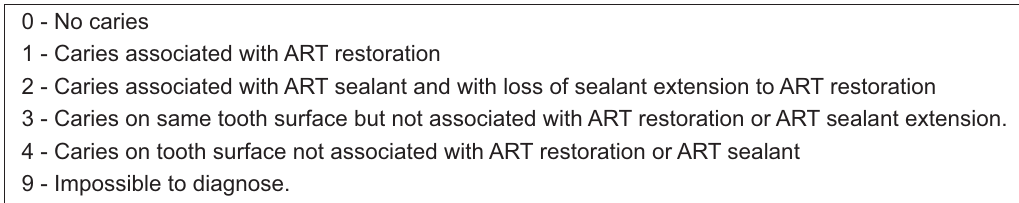
Figure 3 - Criteria for diagnosing carious lesions in ART studies